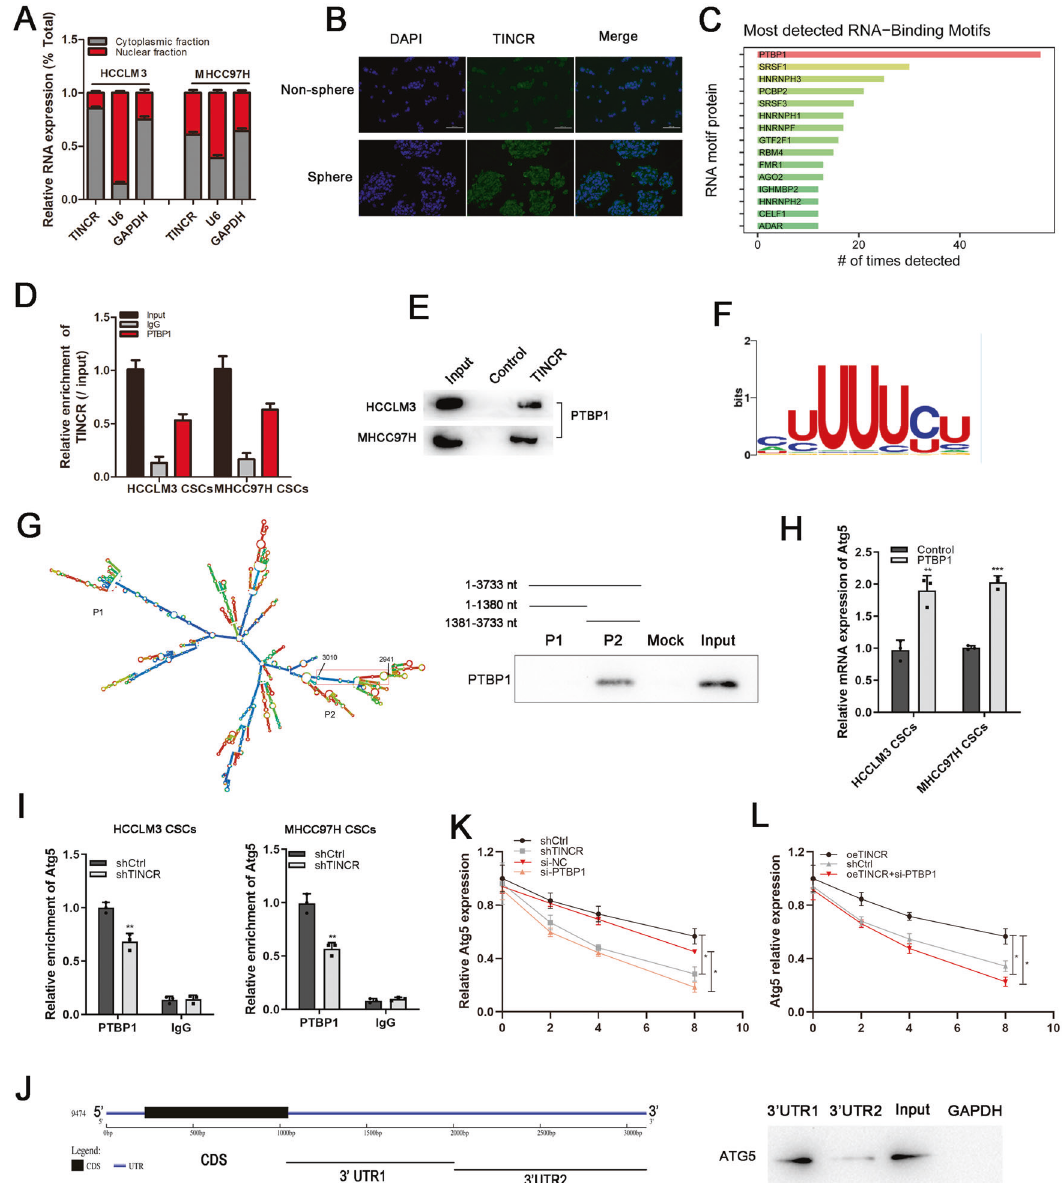
Fig. 5 TINCR stabilized ATG5 mRNA by interacting with PTBP1. A , B Cellular fractionation and RNA-ISH assay were conducted to found cytoplasmic localization of TINCR. Scale bar, 100 mm. C catRAPID omics predicted the protein-RNA interactions. D , E RNA pull-down showed that PTBP1 interacted with TINCR. F RBPsuite (http://www.csbio.sjtu.edu.cn/bioinf/RBPsuite/) predicted the sequence motifs of PTBP1 binding sites. G RNAalifold (http://rna.tbi.univie.ac.at/cgi-bin/RNAWebSuite/RNAalifold.cgi) predicted the secondary structure of TINCR. The PTBP1 binding stem-loop structures in TINCR was indicated by red border. Pull-down assay and western blot were then performed to identify regions required for TINCR and PTBP1 interaction. H Relative ATG5 mRNA was detected by qRT-PCR when PTBP1 was overexpressed. I RIP assay was performed to detect the interaction between ATG5 and PTBP1 after TINCR knockdown. J Schematic description of the ATG5 mRNA 5 ′ UTR, CDS, and 3 ′ UTR. The interaction between PTBP1 and ATG5 mRNA 3 ′ UTR was examined by pull-down analysis. K ATG5 mRNA stability was assessed in LCSCs with silencing TINCR or PTBP1 after being treated with actinomycin D. L ATG5 mRNA stability was evaluated in cells with overexpressed TINCR or combined with PTPB1 knockdown. Data are shown as means ± SD. * p < 0.05, ** p < 0.01, *** p <